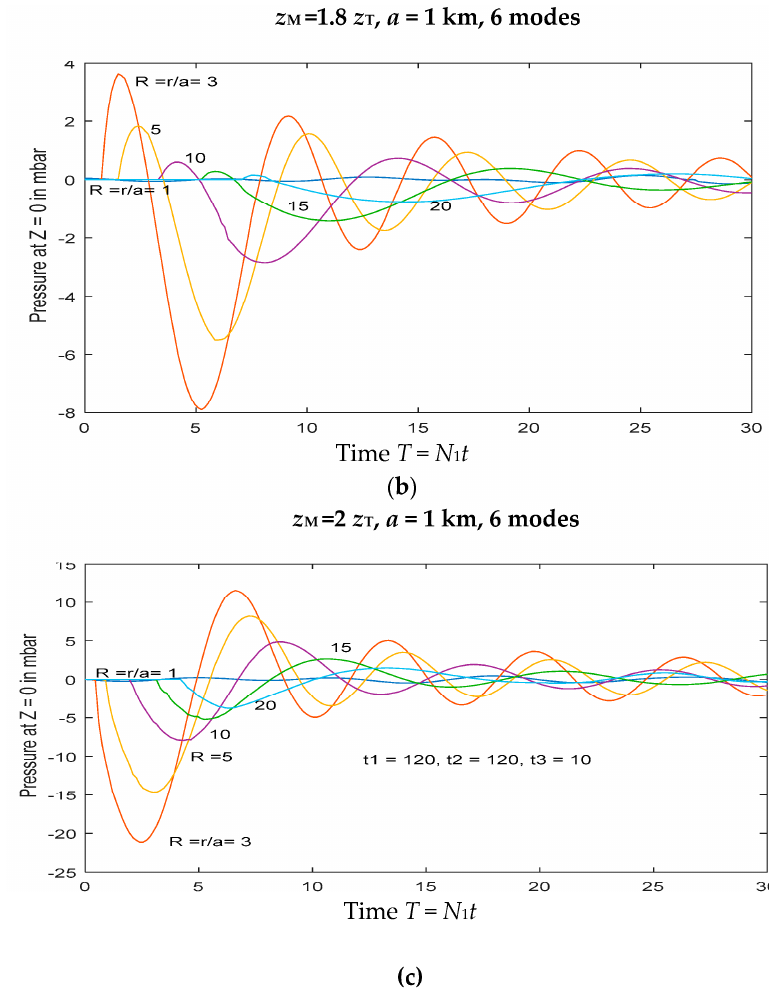
Figure 7. The time series of surface pressure signals in mb, forced at radius a = 1 km within the stratosphere at distances R = r / a = 1, 3, 5, 10, 15 and 20 for eruptions that reach maximum heights z M where z M / z T = ( a ) 1.2, ( b ) 1.6, and ( c ) 2. Here, z T = 14 km, H s = 9 km, and B ( n ) coefficients are given in Figure A3. There is an increasing amplitude and progressive change in sign of the response with increasing z M for z M > 1.4.